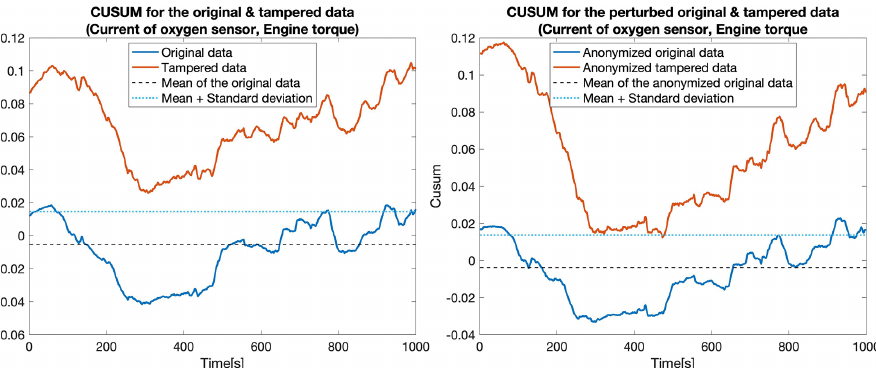
Figure 11. CUSUM for the original data (blue) and tampered data (orange) for sensors: Current of oxygen sensor and Engine torque .